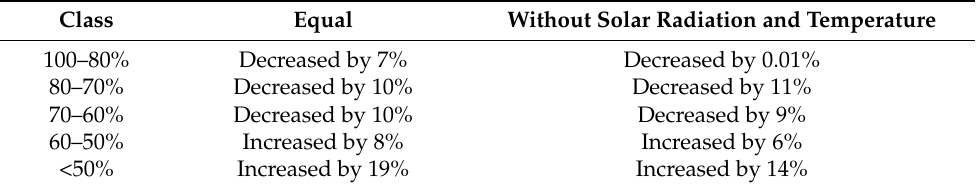
Table 15. Difference between the original map and two scenarios around the whole study area.